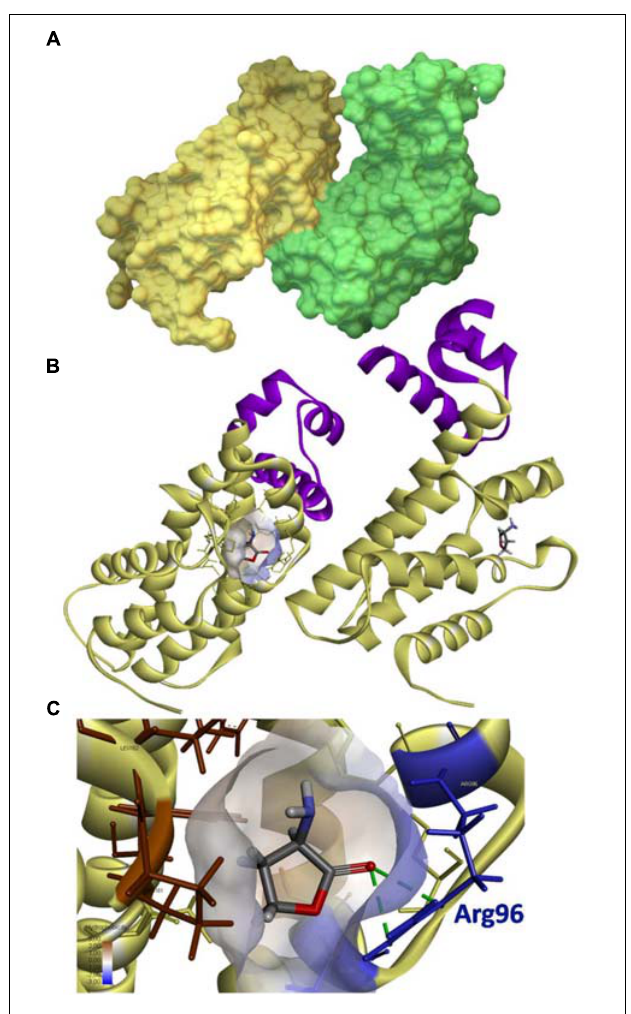
FIGURE 5 | 3D structure of QsdR and its potential ligand. The QsdR structure of the R138 strain (RCSB PDB accession number 4ZA6) was elucidated after crystallization and X-Ray diffraction (El Sahili et al., 2015). (A) A solvent-accessible surface area representation shows the functional structure of QsdR consisting of two monomers (yellow and green) that interact asymmetrically. (B) A secondary structure representation shows that each monomer presents both a DNA-binding domain (N-domain) colored in purple and an effector binding domain (C-domain) indicated in yellow, this last one harboring at the core a narrow half apolar/half polar cavity (drawn only on one of the monomers). (C) A close-up of the core cavity and HSL ligand are presented. Molecular docking methodology predicts a binding of the homoserine lactone (HSL), which is also the cyclic moiety of the QS signal, in each of the effector pockets (B,C) . The lactone ester bond of the homoserine lactone is oriented toward the hydrophilic part of the pocket (colored in translucent blue) while the rest of the ligand molecule is oriented toward the hydrophobic part (colored in translucent brown). The hydrogen bonds between the oxygen atom of lactone carbonyl and the nitrogen atoms of Arg96 residue are indicated in green dashed